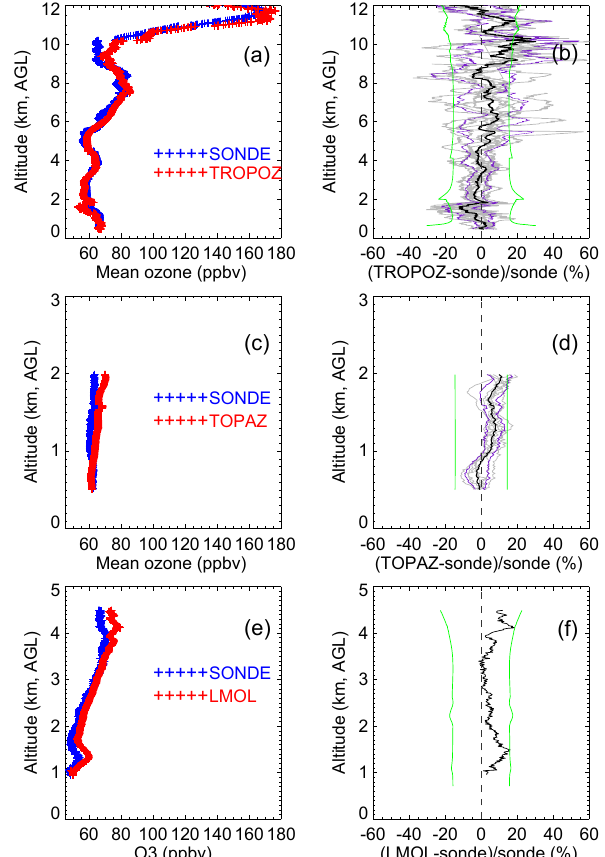
Figure 3. Comparisons of lidar and ozonesonde measurements. (a) Average ozone profiles measured by TROPOZ and ozonesondes at Fort Collins, CO (11 pairs). (b) Mean relative difference (black) between TROPOZ and ozonesondes as well as the 1 σ standard de- viations (purple). (c) Average ozone profiles measured by TOPAZ and ozonesondes at BAO tower (7 pairs). (d) Mean relative differ- ence (black) between TOPAZ and ozonesondes as well as the 1 σ standard deviations (purple). (e) Average ozone profiles measured by LMOL and ozonesonde at the BAO tower (1 pair). (f) Relative difference between LMOL and ozonesonde. The gray lines repre- sent the individual difference profiles between the lidar and son- des. The green lines represent the expected uncertainties, including the 30min lidar measurement uncertainties (also see Table 2) and a 10% constant uncertainty for ozonesondes.